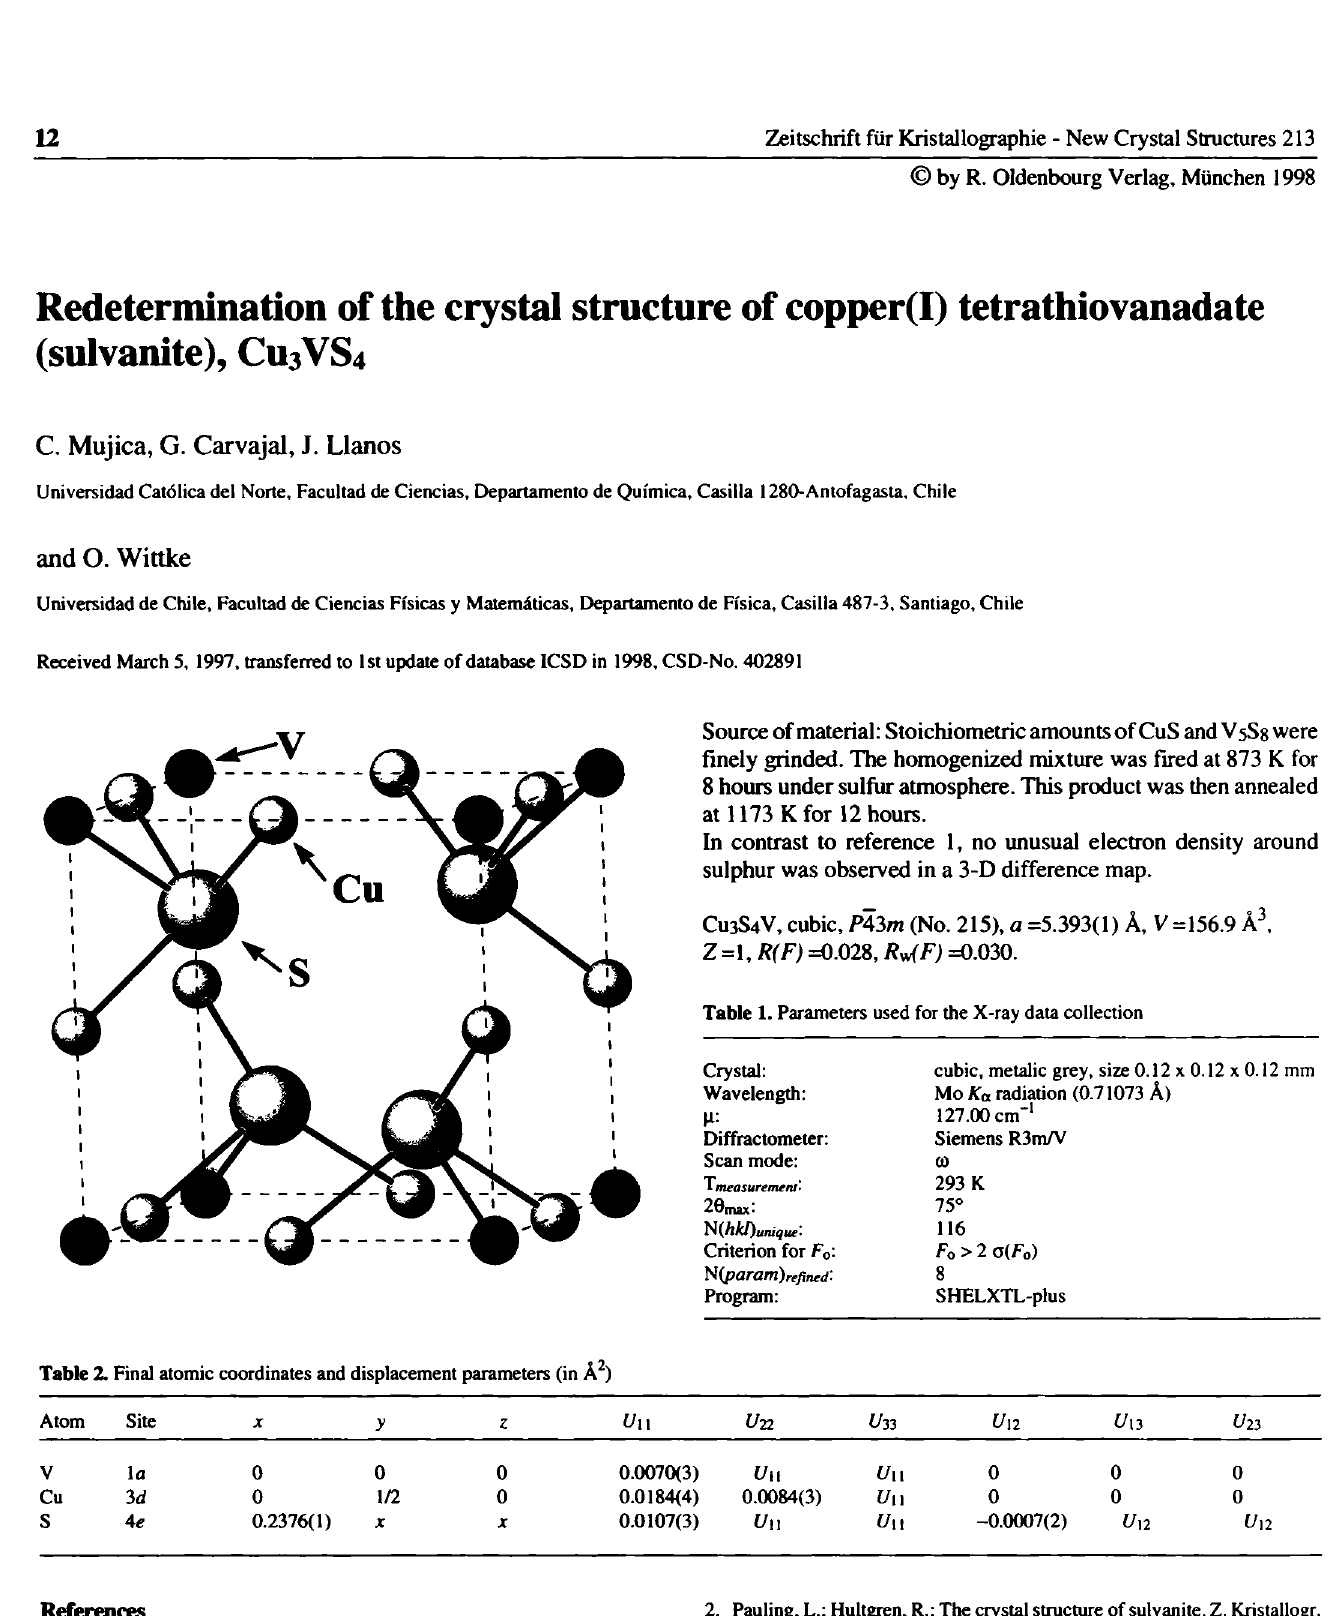
Table 2. Final atomic coordinates and displacement parameters (in A^) Atom Site